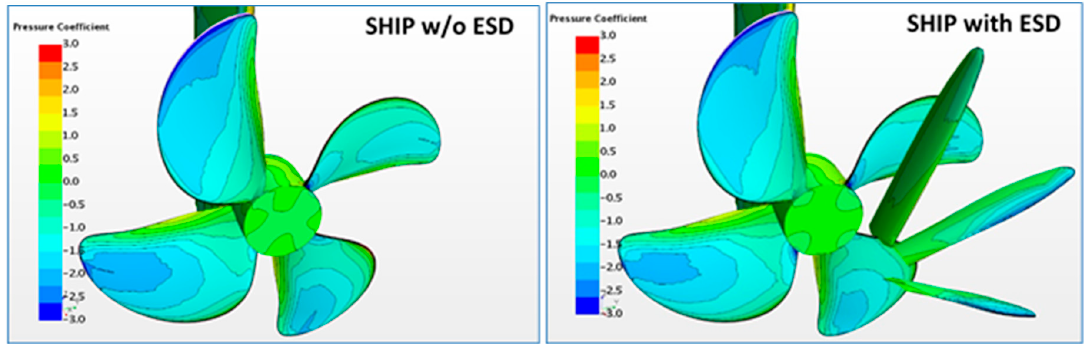
Figure 14. Cavitation domains on propeller and ESD. (PSS-Var-5, full scale, Vs = 14 kn, ballast draught).